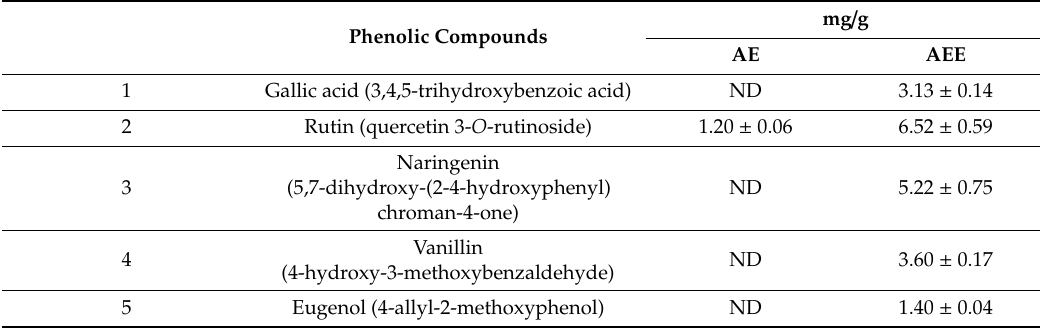
Table 1. Detection and quantification of the phenolic composition of Annona muricata L., considering both